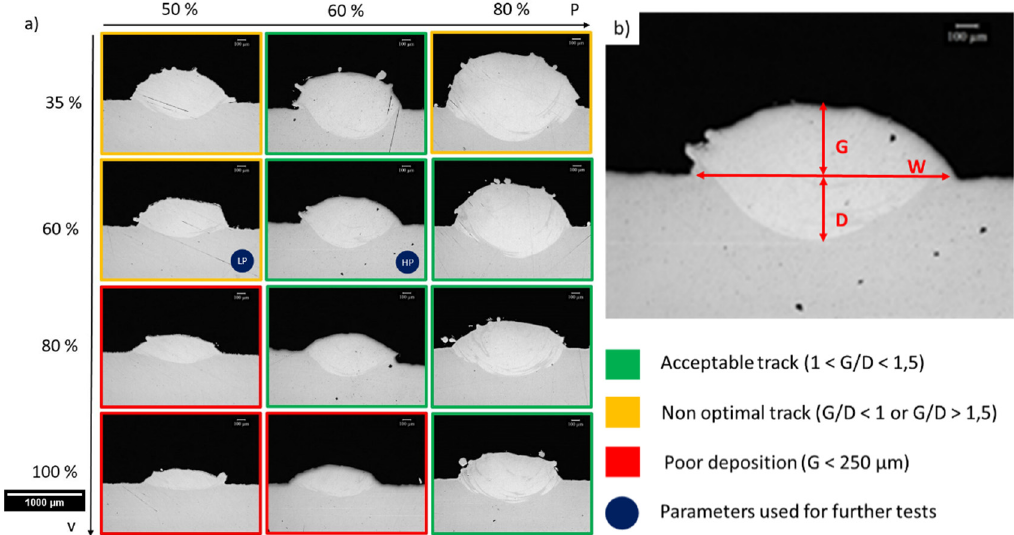
Figure 2. ( a ) Representative cross-section images of SSTs built with different combinations of P and v, ( b ) schematic representation of measurements.